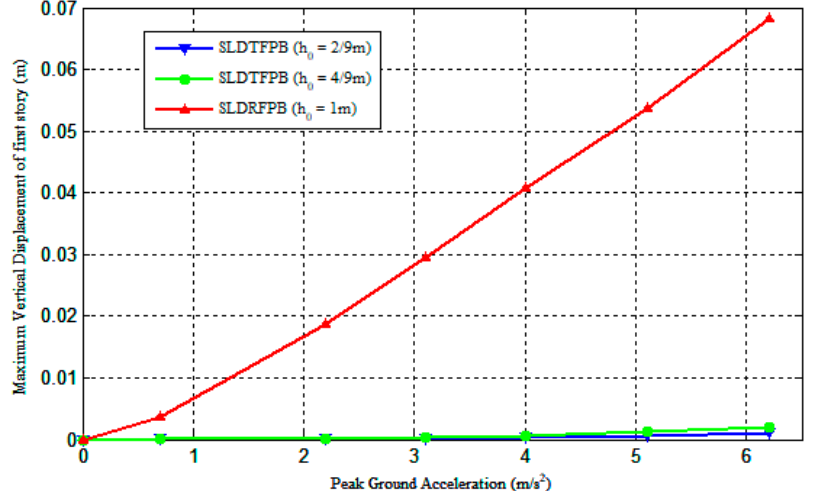
Figure 15. Maximum vertical displacements of superstructures equipped with SLDRFPB or SLDTFPB.